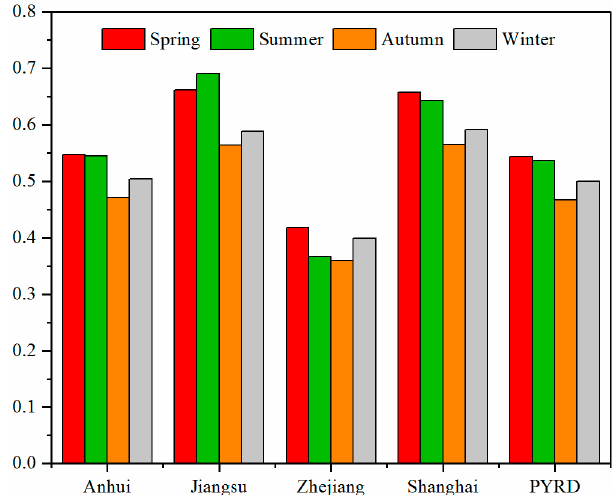
Figure 8. Seasonal average AOD over the PYRD and its four parts from 2014 to 2017.